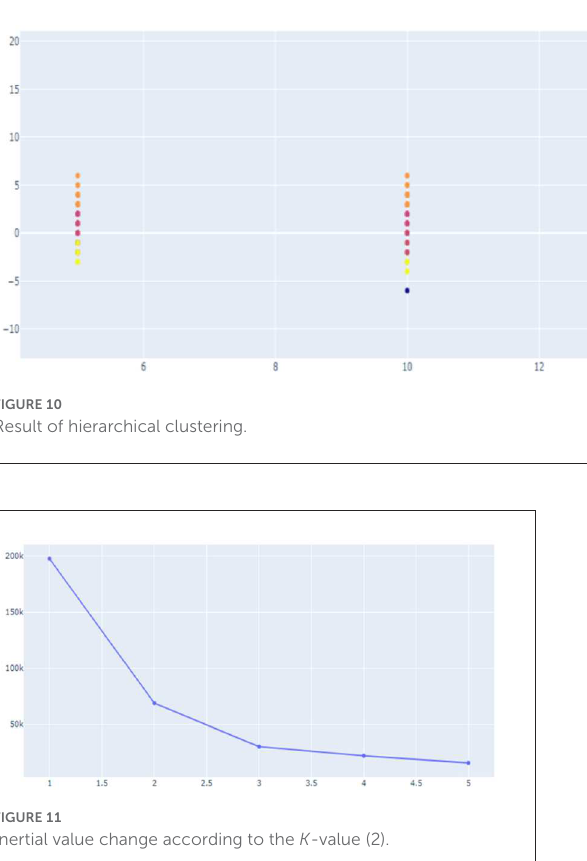
FIGURE11 Inertial value change according to the K -value